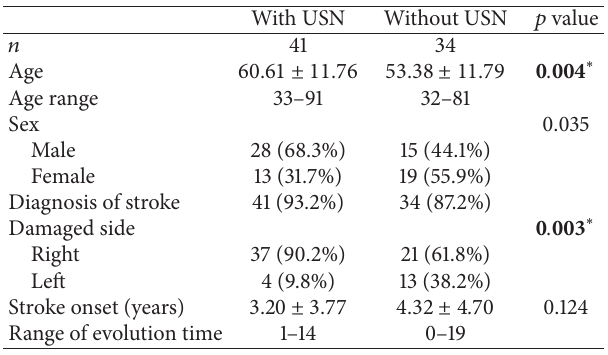
Table 2: Data on stroke patients with and without unilateral spatial